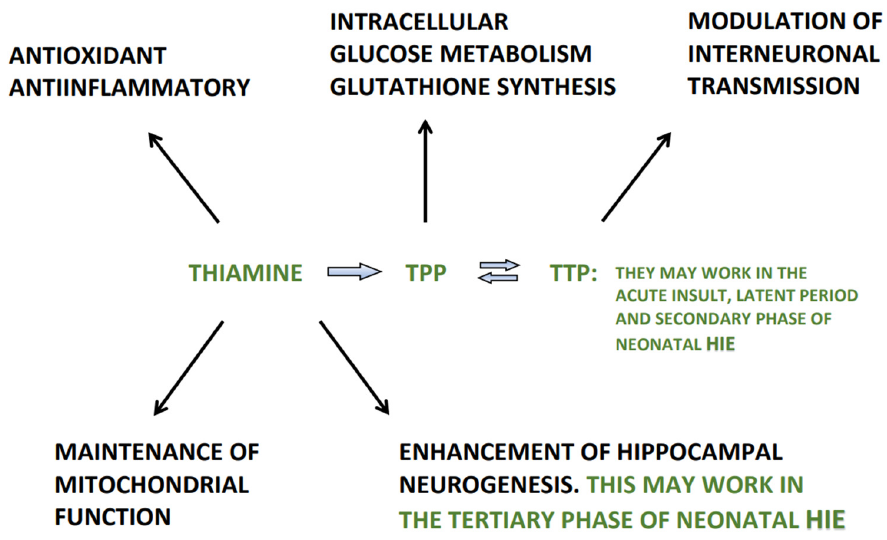
Figure 3. Main mechanisms of action of thiamine and its derivatives in the different phases of neonatal HIE. TPP = thiamine pyrophosphate; TTP = thiamine triphosphate.